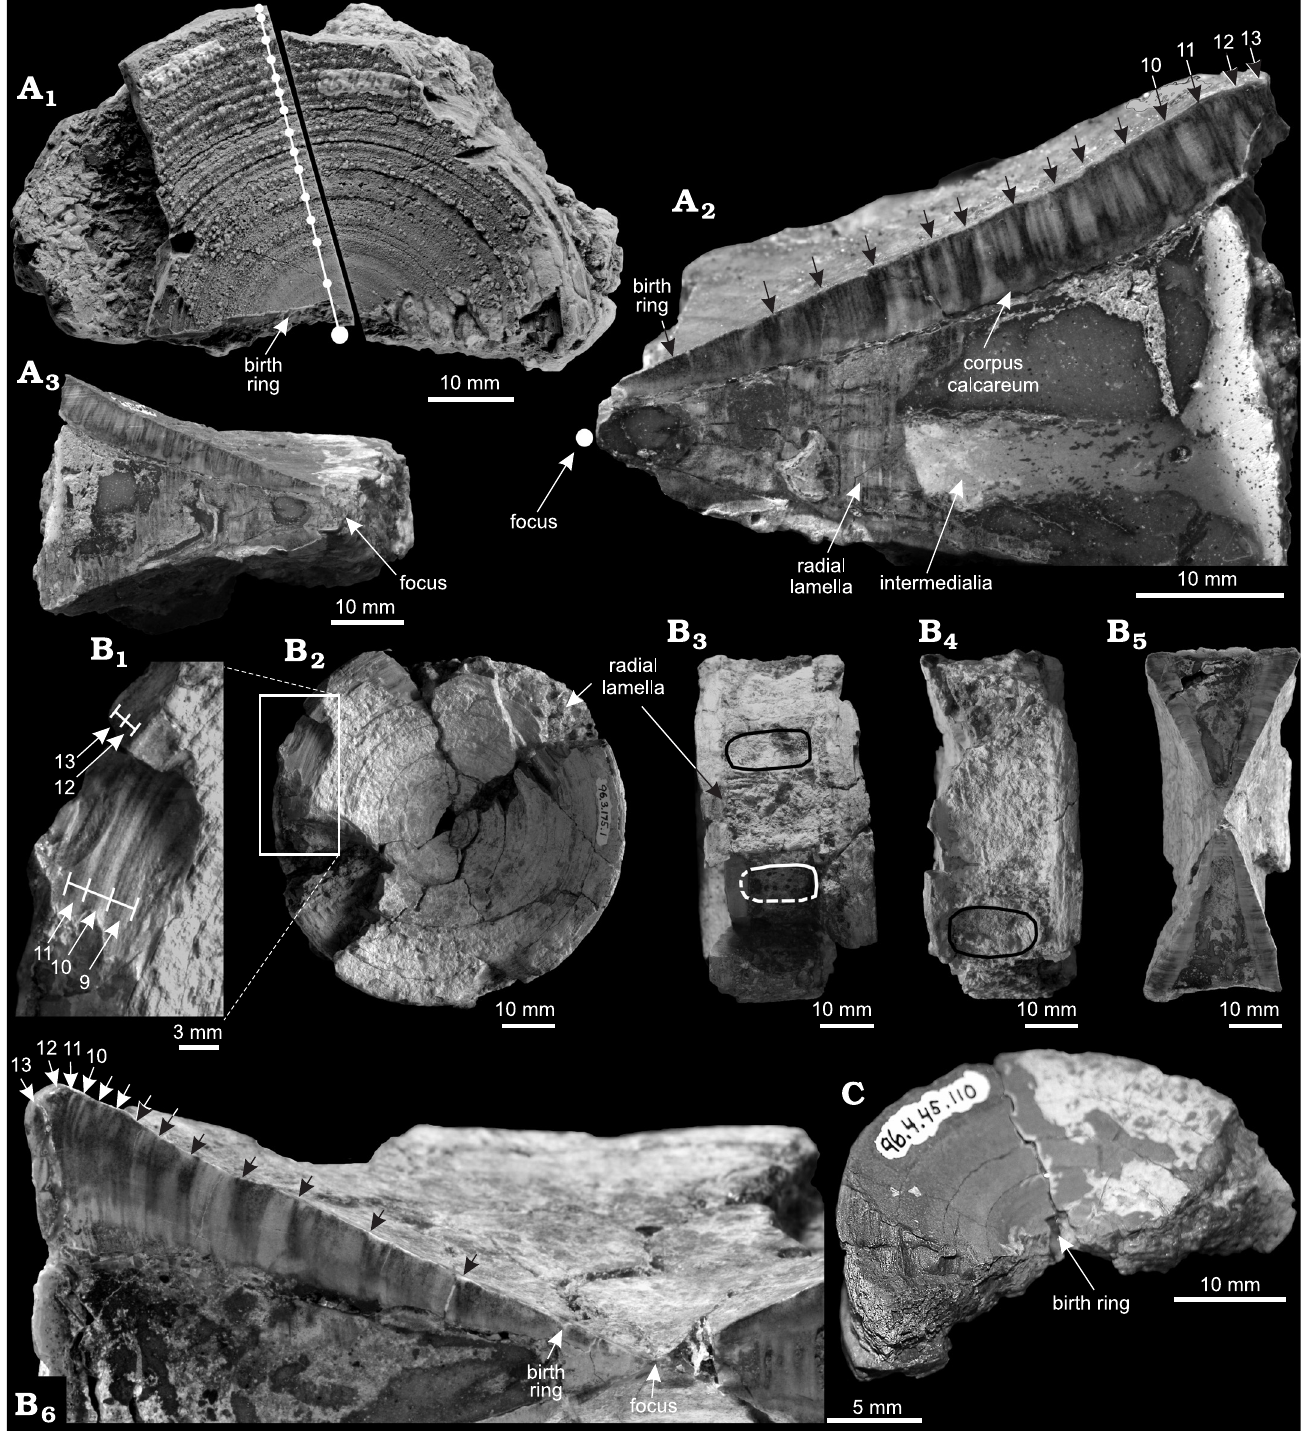
Fig. 5. Centra of Cardabiodon ricki Siverson, 1999 from uppermost 10 cm of the Gearle Siltstone (middle Cenomanian), CY Creek, Giralia Range, West- ern Australia. A . Precaudal centrum, WAM 96.4.45.128. Face of the corpus calcareum (A ) showing line of section (black line) and transect with points 1 of measurement (white line and circles), large filled circle represents focus, left half of the section centrum correseponds to A , right half of the centrum 2 corresponds to A . “Hemisected” view of centrum (A ) showing the number of bands, angle of the section does not intersect the focus as it was missing 3 2 from the originally incomplete centrum, the point of the focus occurs in -z space (behind the plain of the page). Opposing view showing focus (A ). B . Pre- 3 caudal centrum, WAM 96.3.175.1. Anterior view of corpus calcareum with surface removed to show bands (B ); centrum (B ); dorsal view of centrum 1 2 (B ), ovals show outline and position of articular foramina for the neural arch (anterior to left); lateral view of centrum (B ) oval outlines rib articular 3 4 foramen (anterior to left); hemisected section of centrum (B ) (anterior to left); enlarged, hemisected view (B ) showing bands. C . Caudal centrum, WAM 5 6 96.4.45.110 (oblique angle), anterior view showing birth